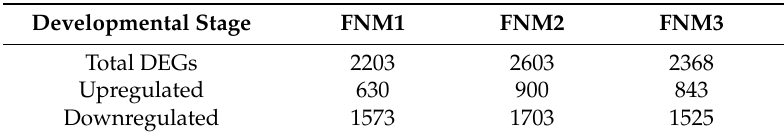
Table 4. Differentially expressed genes (DEGs) in FL vs. SL ovules at three free nuclear mitosis (FNM) stages in FG development.